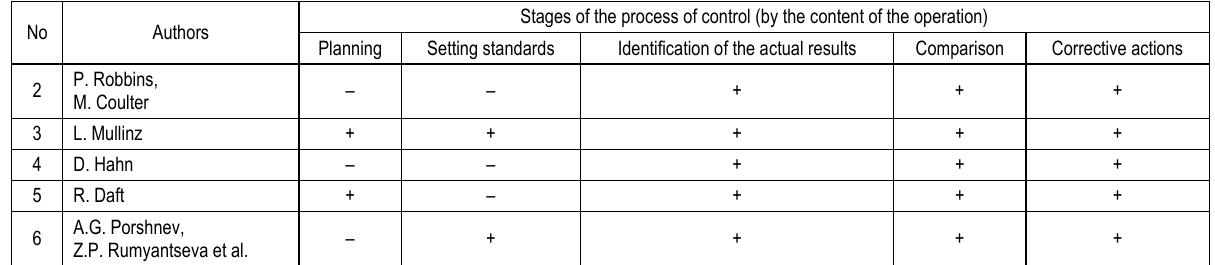
Table 1 (cont.). Authors and stages of the process of control they propose